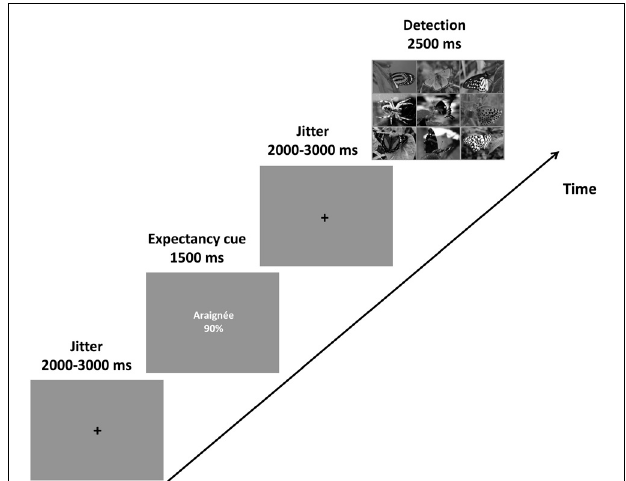
FIGURE 1 | Task sequence. An example of a spider-90% cue [araignée (French word for spider) 90%] followed by a search array depicting a spider target. Participants were told that the cues described the likelihood of a spider or a bird being the deviant in the search array. They were asked to respond as quickly and accurately as possible according to the target (i.e., spider, bird, or no target).